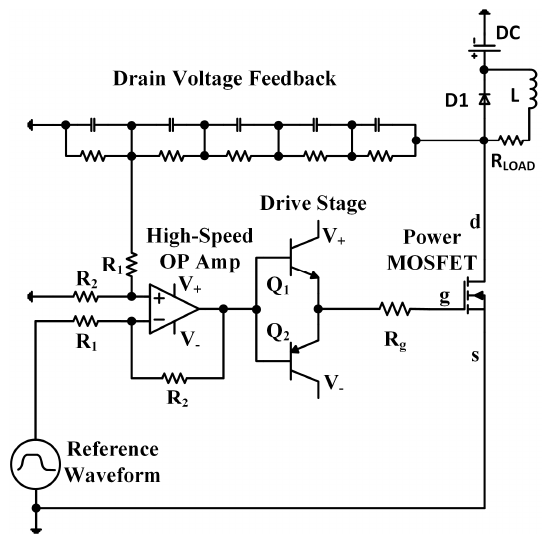
Figure 1. A standard chopper cell applied closed-loop gate drive for switching transient modification.